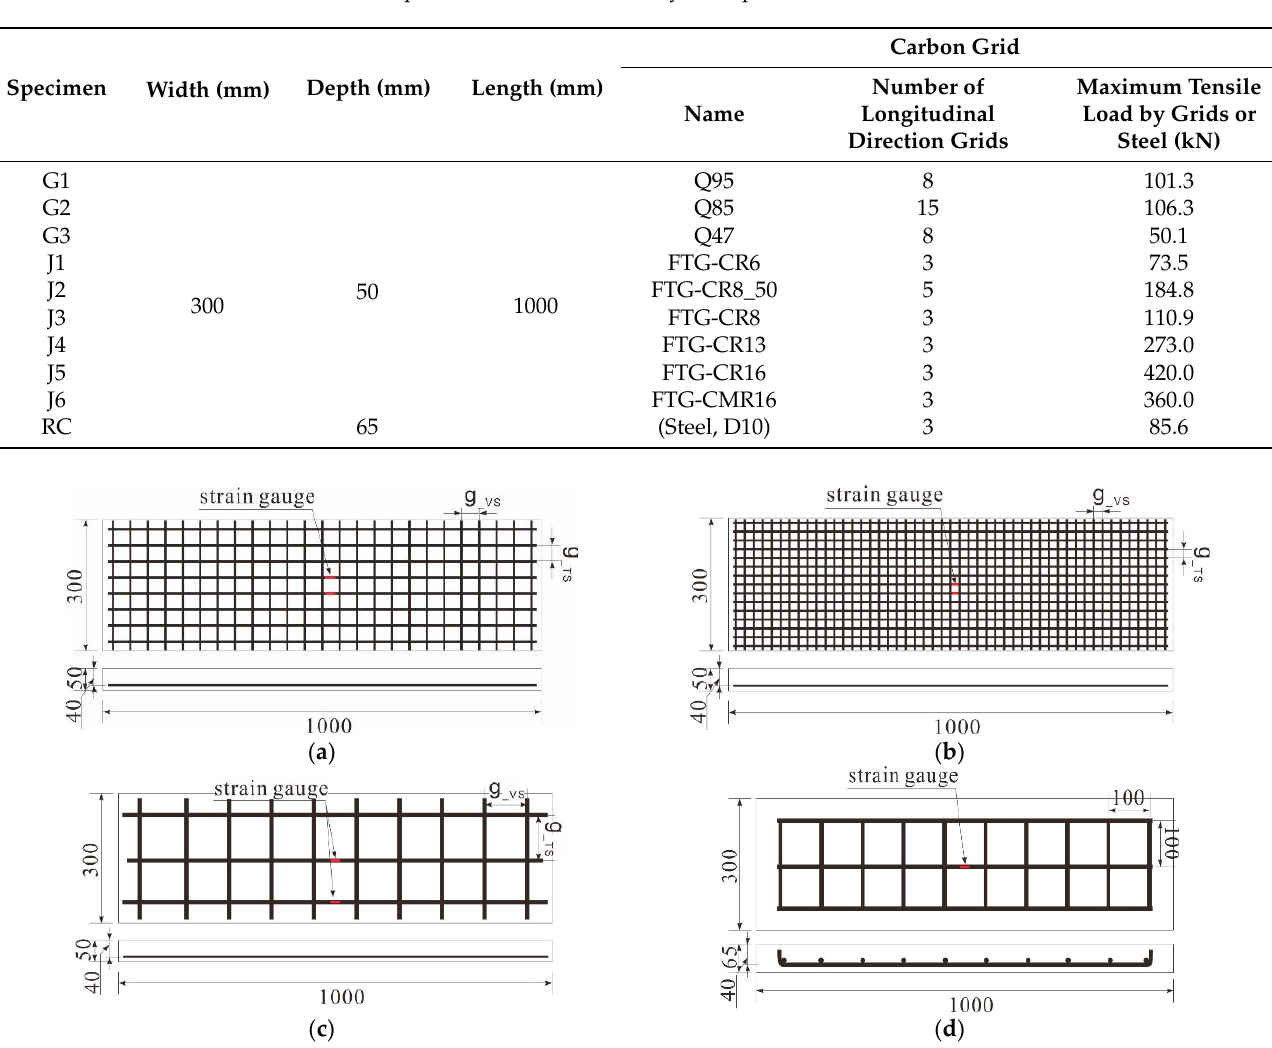
Table 1. Specifications of the one-way slab specimens.